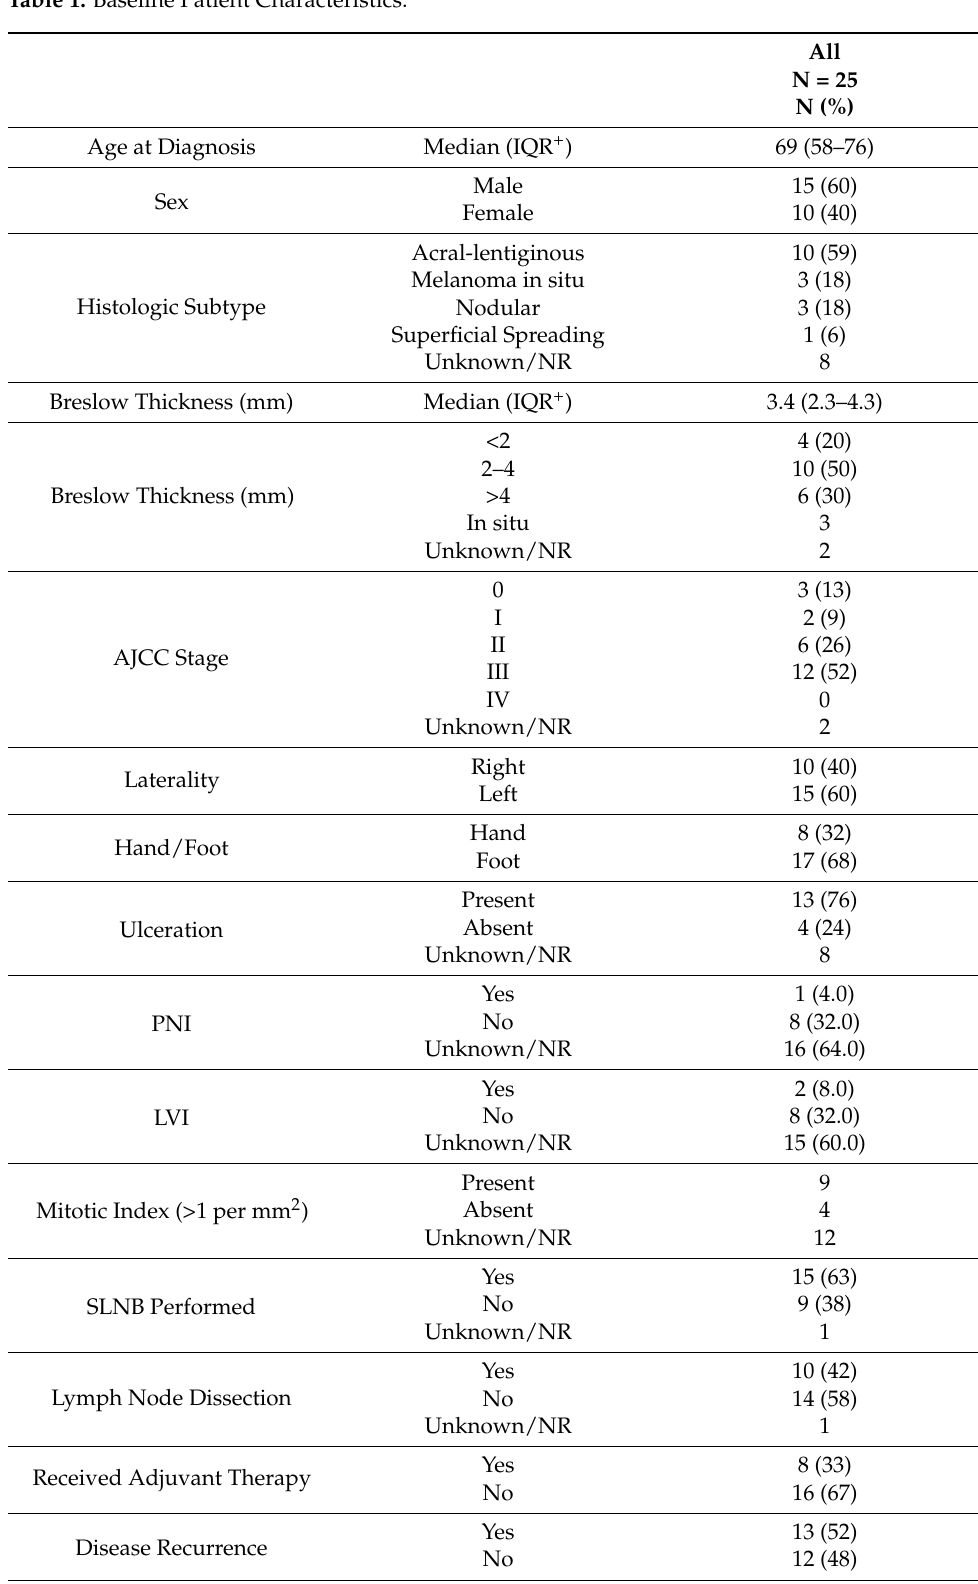
Table 1. Baseline Patient